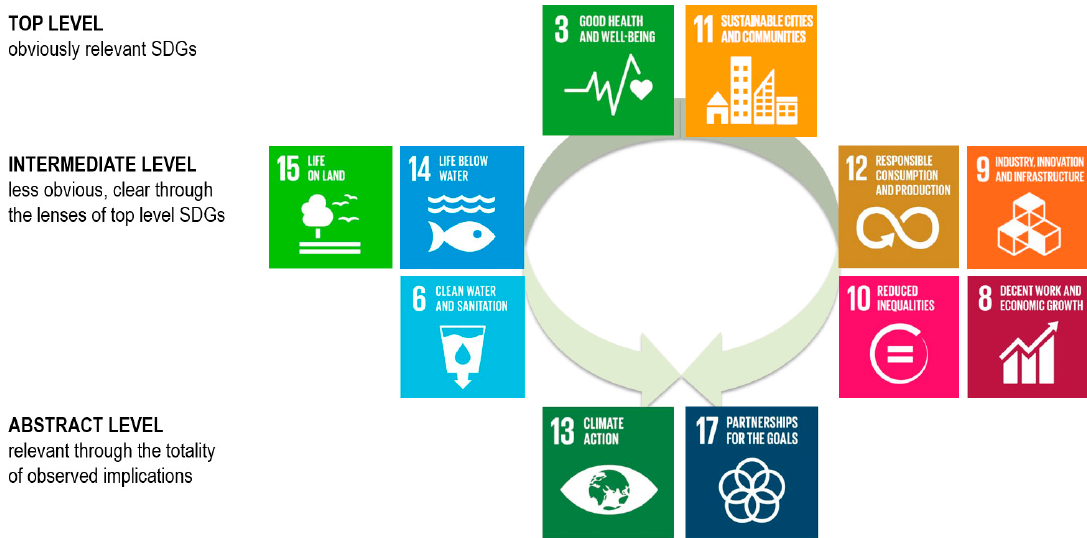
Figure 1. Diagram of relevant Sustainable Development Goals (SDGs) for assessing healthiness of building materials (Diagram: Emina Kristina Petrovi ć .).